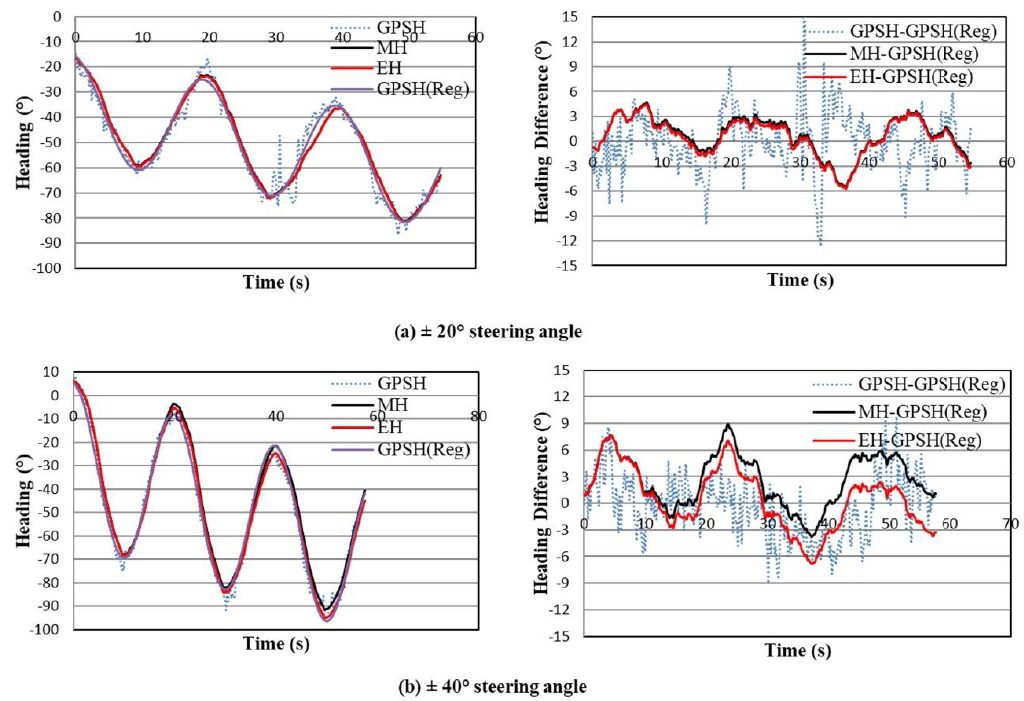
Figure 7. Measured and estimated headings (left figures) for sinusoidal trajectories as well as heading difference (right figures) (where, GPSH = GPS Heading, MH = Measured Heading, EH = Estimated Heading and GPSH (Reg) = Non-linear Regression of GPS Heading).